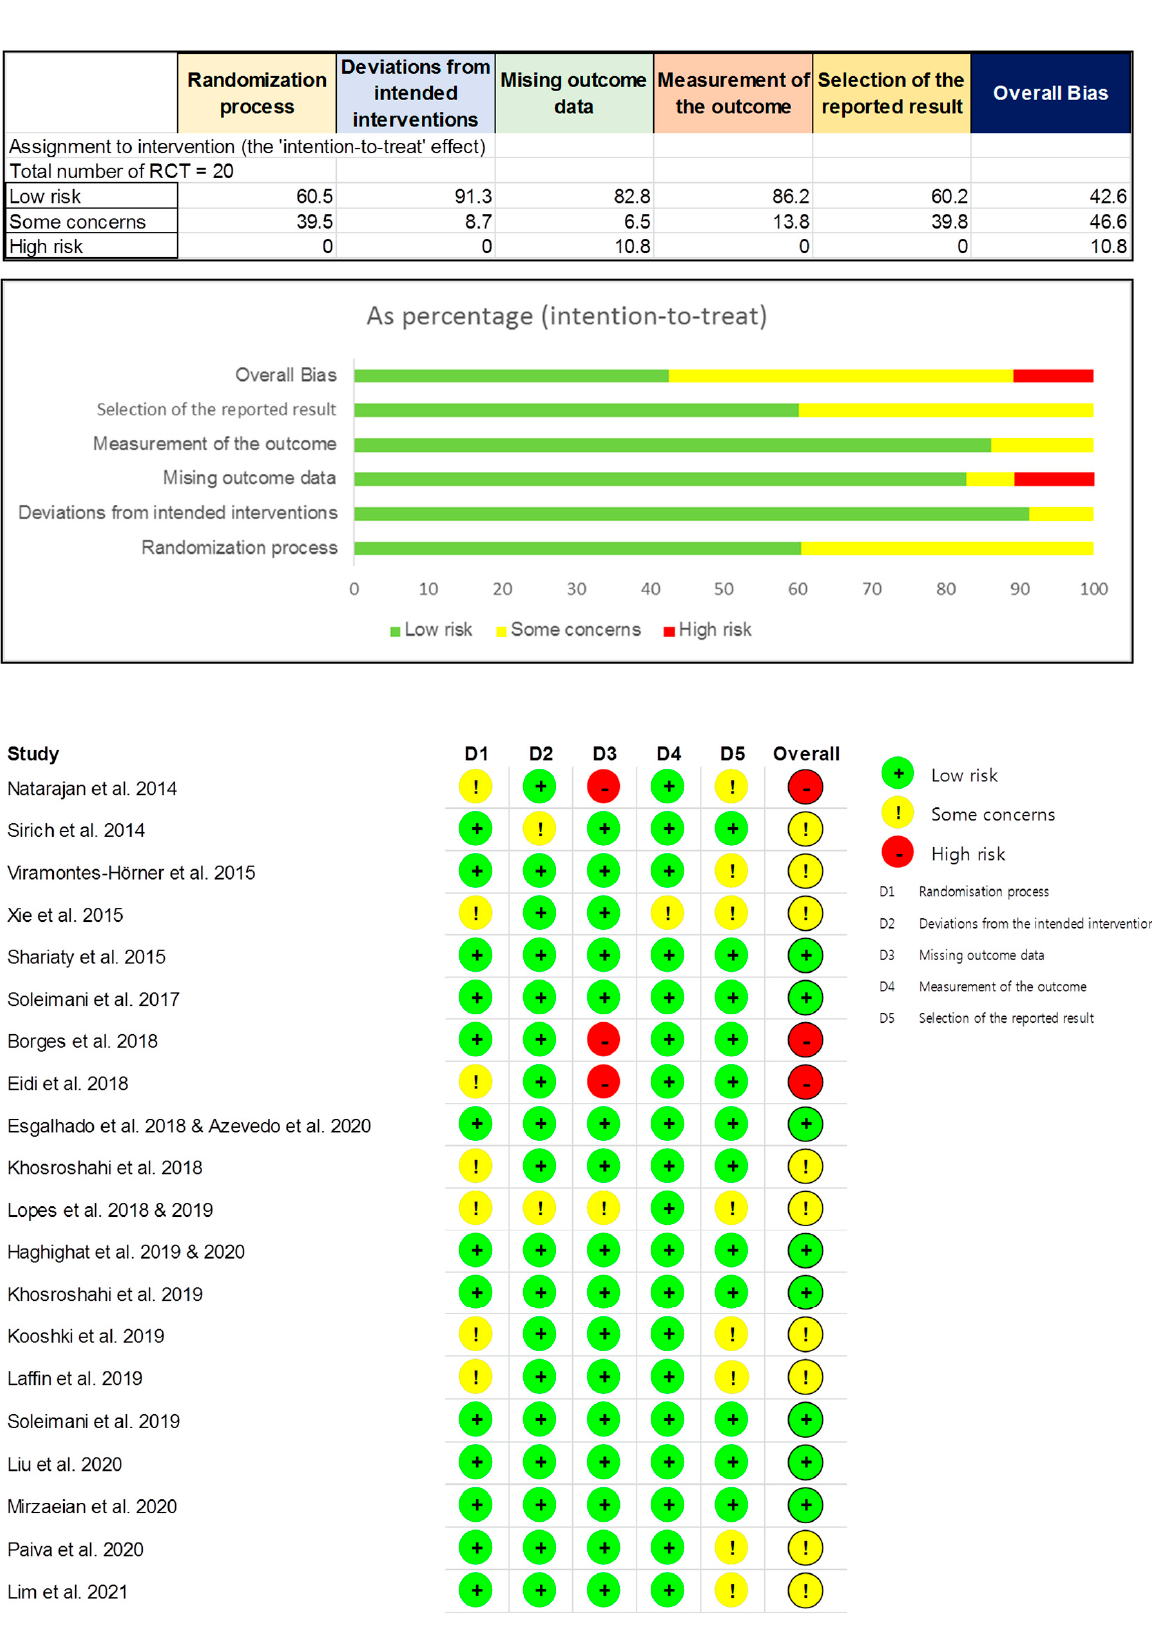
Figure 2. Risk of bias assessment for included RCTs using version 2 of Cochrane risk-of-bias tool for randomized trials.